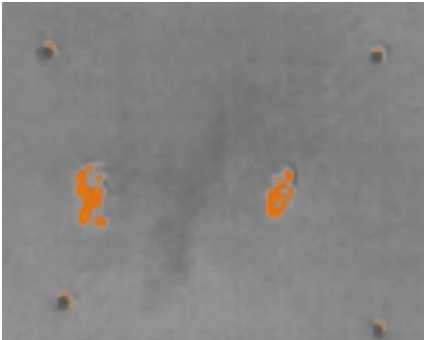
Figure 3. Cropped thermal imagery at an altitude of 70 metres.